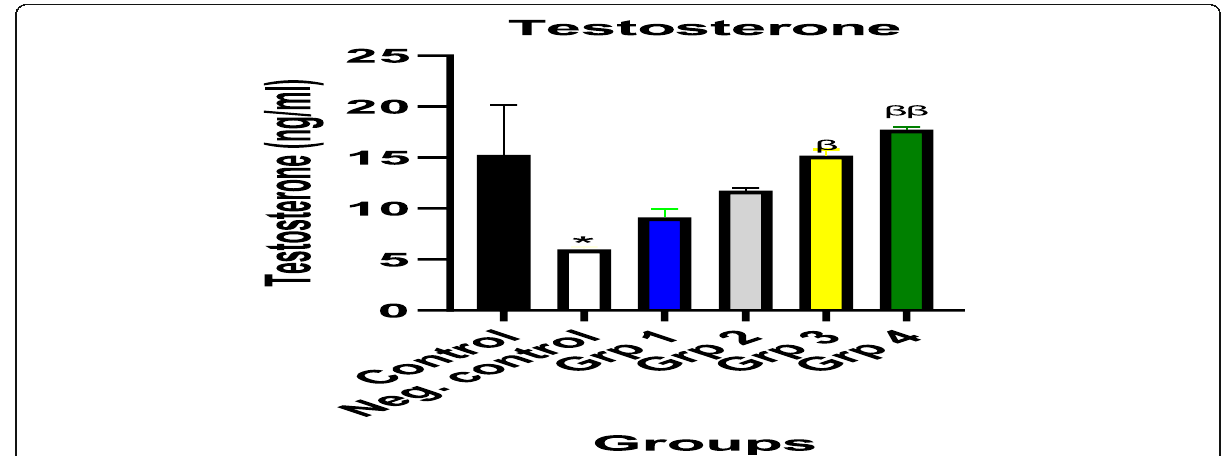
Fig. 4 Representation of testosterone hormone level. (*) Negative control group was significant ( p < 0.05), when control was compared with the other groups. ( β ) Groups 3 and 4 were significant ( p < 0.05), when negative control was compared with other